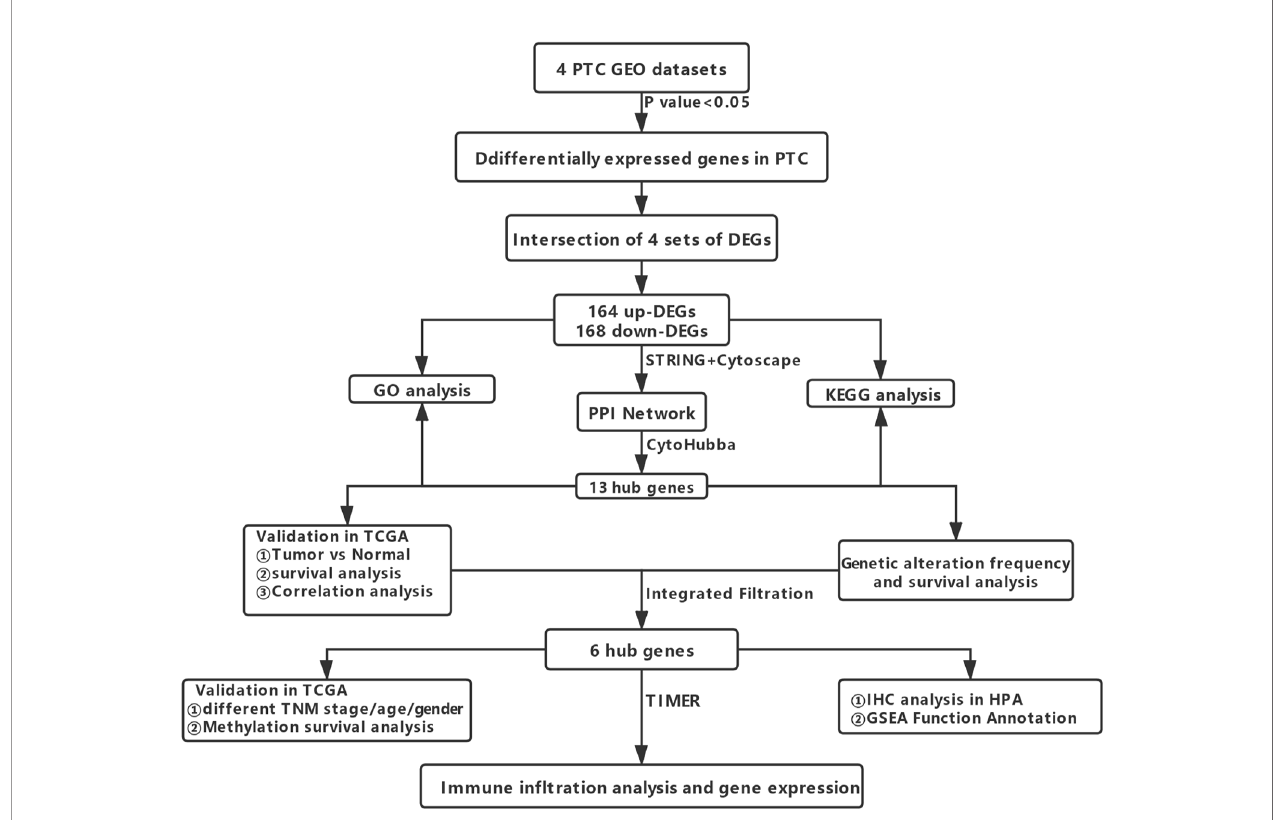
FIGURE 1 | Flowchart showing the work fl ow for the identi fi cation, functional analysis, and veri fi cation of